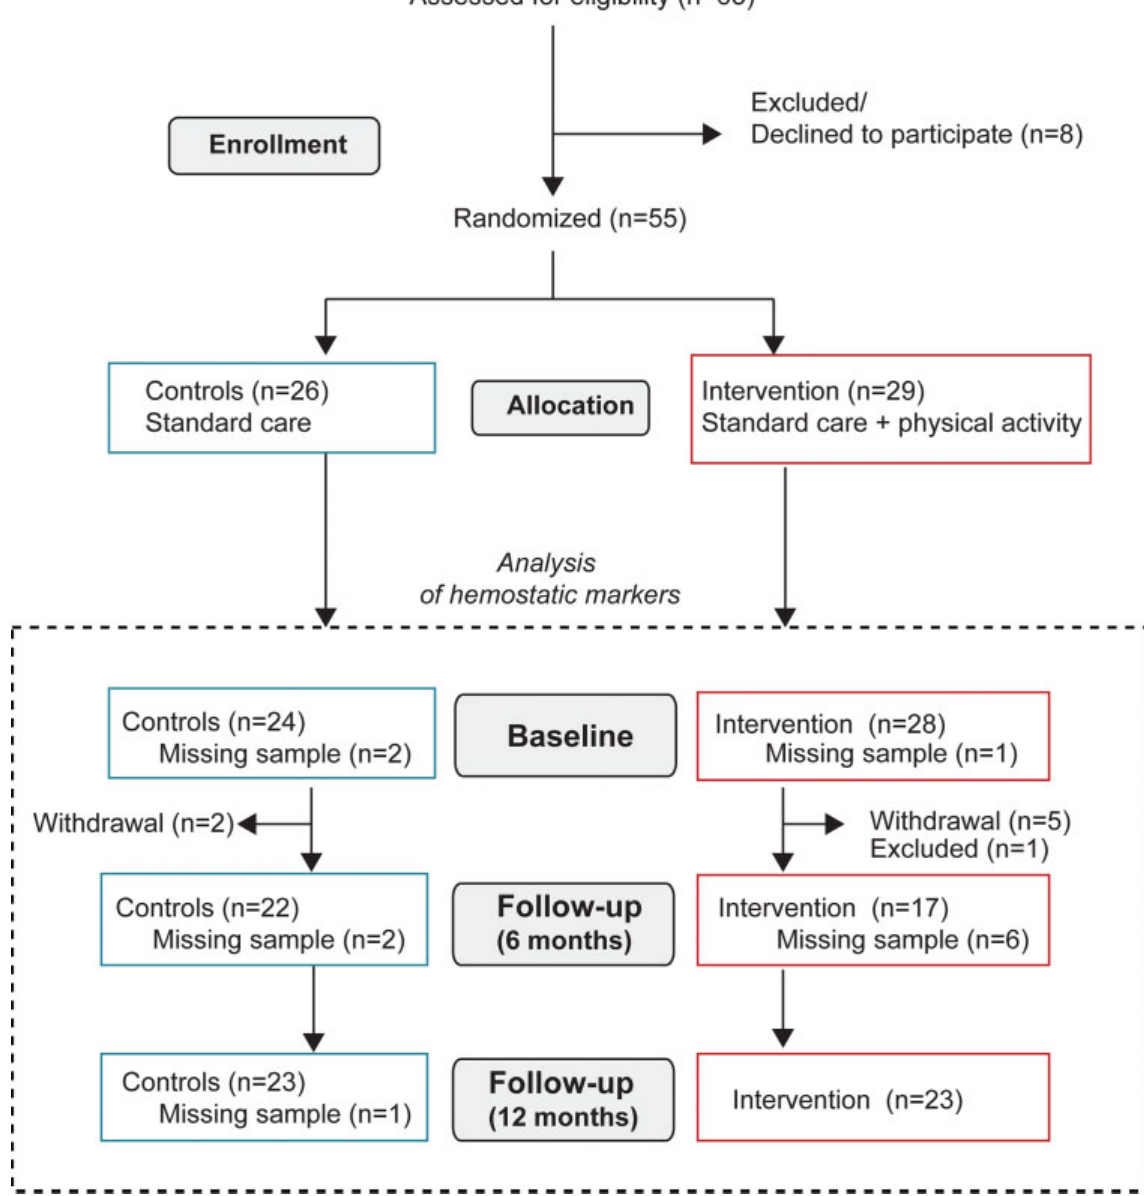
Fig. 1 Flow chart showing the inclusion process of the patients in the study. Maximum number of available samples for the analyses of hemostatic markers is indicated. Note that the number of missing samples was higher for some of the hemostatic markers, as indicated in the tables.